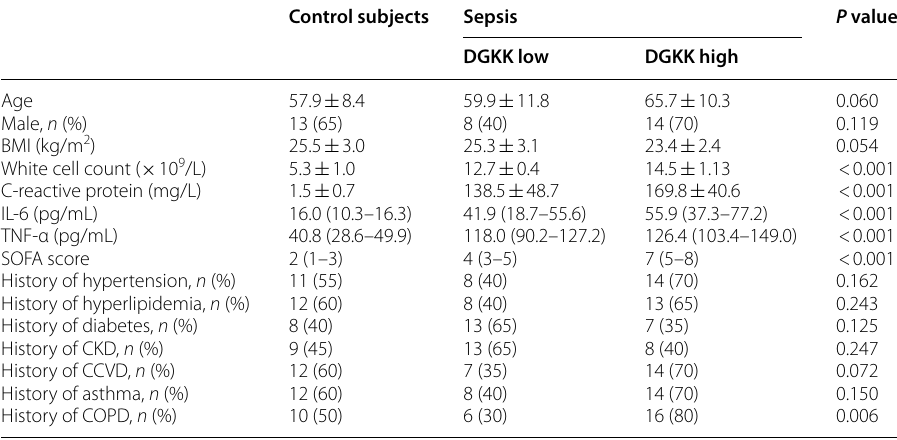
Table 2 Relationship between DGKK expression and clinicopathological features of patients with sepsis‑induced lung injury Control subjects Sepsis P value DGKK low DGKK high Age Male, n (%) BMI (kg/m 2 ) White cell count ( 10 9 /L) × C‑reactive protein (mg/L) IL‑6 (pg/mL) TNF‑α (pg/mL) SOFA score History of hypertension, n (%) History of hyperlipidemia, n (%) History of diabetes, n (%) History of CKD, n (%) History of CCVD, n (%) History of asthma, n (%) History of COPD, n Results expressed as mean SD or median (interquartile range) ± CKD chronic kidney disease, CCVD cardiovascular and cerebrovascular diseases, COPD chronic obstructive pulmonary disease, SOFA sequential organ failure assessment